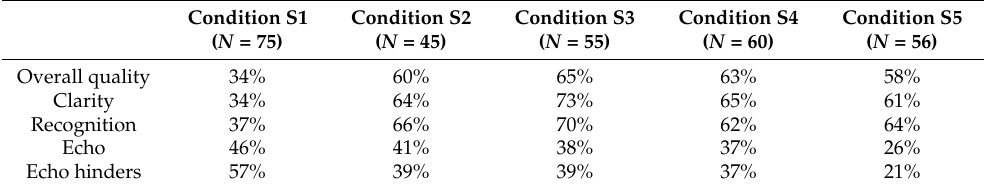
Table 5. The average results of test parameters for student interactions conditions.